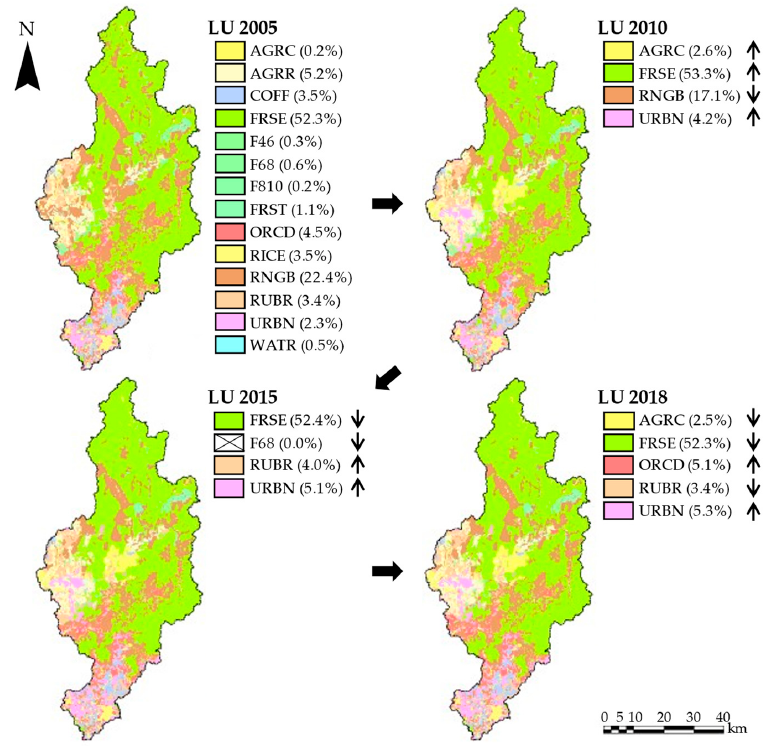
Figure 2. The 2005, 2010, 2015, and 2018 land-use maps in the Dakbla watershed. The major changes in land use are shown in the legend for the 2010, 2015, and 2018 maps. AGRC: agricultural land, nonrow crops; AGRR: agricultural land row crops; COFF: coffee; FRSE: forestry land; F46: mixed forest (400–600 m); F68: mixed forest (600–800 m); F810: mixed forest (800–1000 m); FRST: mixed forest; ORCD: orchard; RICE: rice; RNGB: rangeland; RUBR: rubber; URBN: urban; and WATR: water.